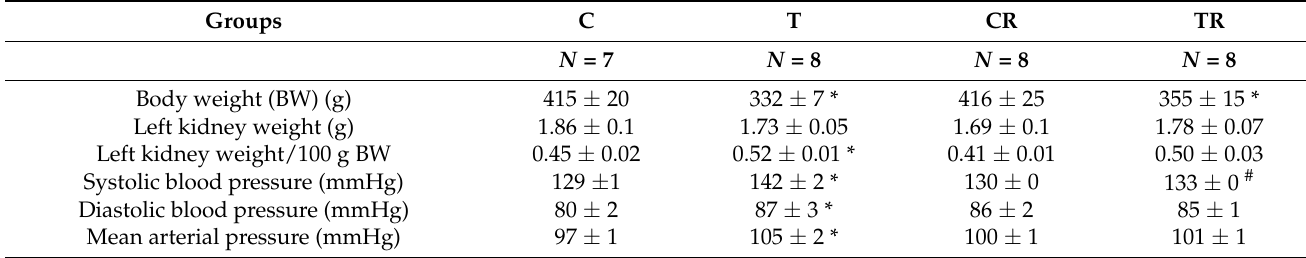
Table 2. Morphological values and blood pressures.